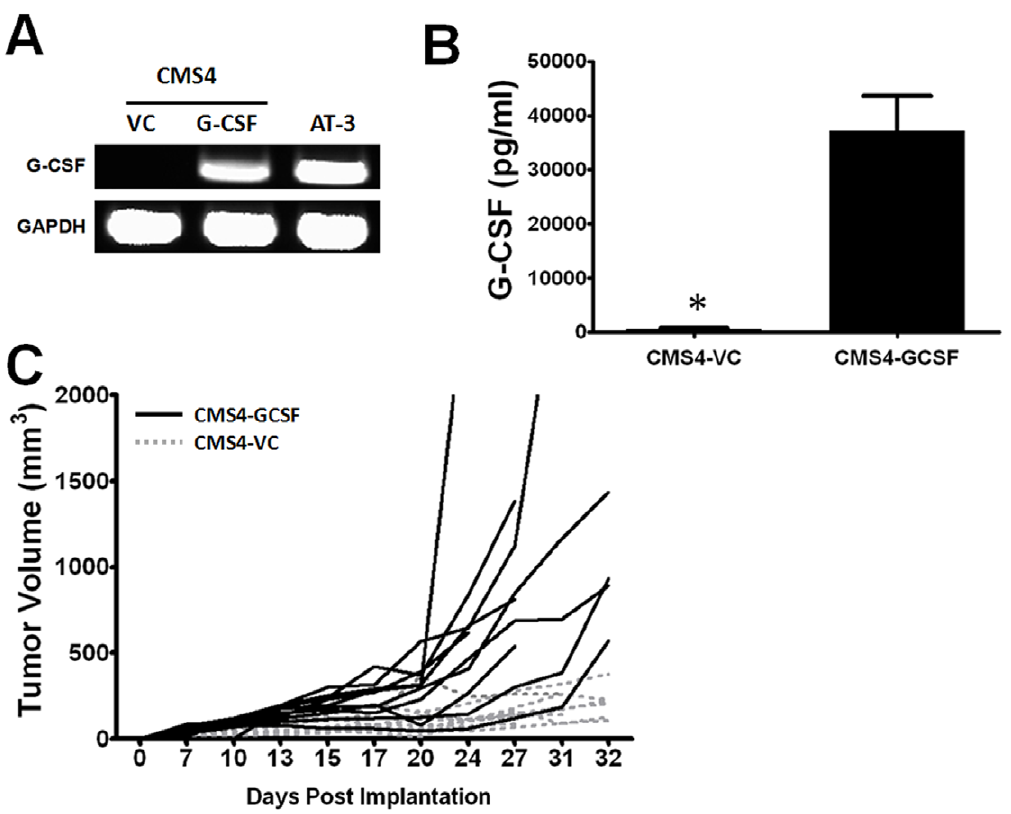
Figure 6. G-CSF over-expression enhances tumor growth invivo . ( A ) RT-PCR analysis for G-CSF or GAPDH mRNA levels performed on parental AT-3 cells or stably transfected CMS4 cells expressing murine G-CSF or the vector control (VC). ( B ) Cell-free supernatants from CMS4 cells of panel A were quantified for G-CSF levels by ELISA. Data are reported as the mean 6 SEM (pg/ml/10 6 cells/24 hr) of 4 separate experiments (* P , 0.0001). ( C ) BALB/c mice were implanted with either G-CSF-producing CMS4 cells or the vector control (4 6 10 5 /mouse) and monitored for tumor growth. In all mice, G-CSF-expressing tumors grew significantly faster than the vector control (n=10 mice each).